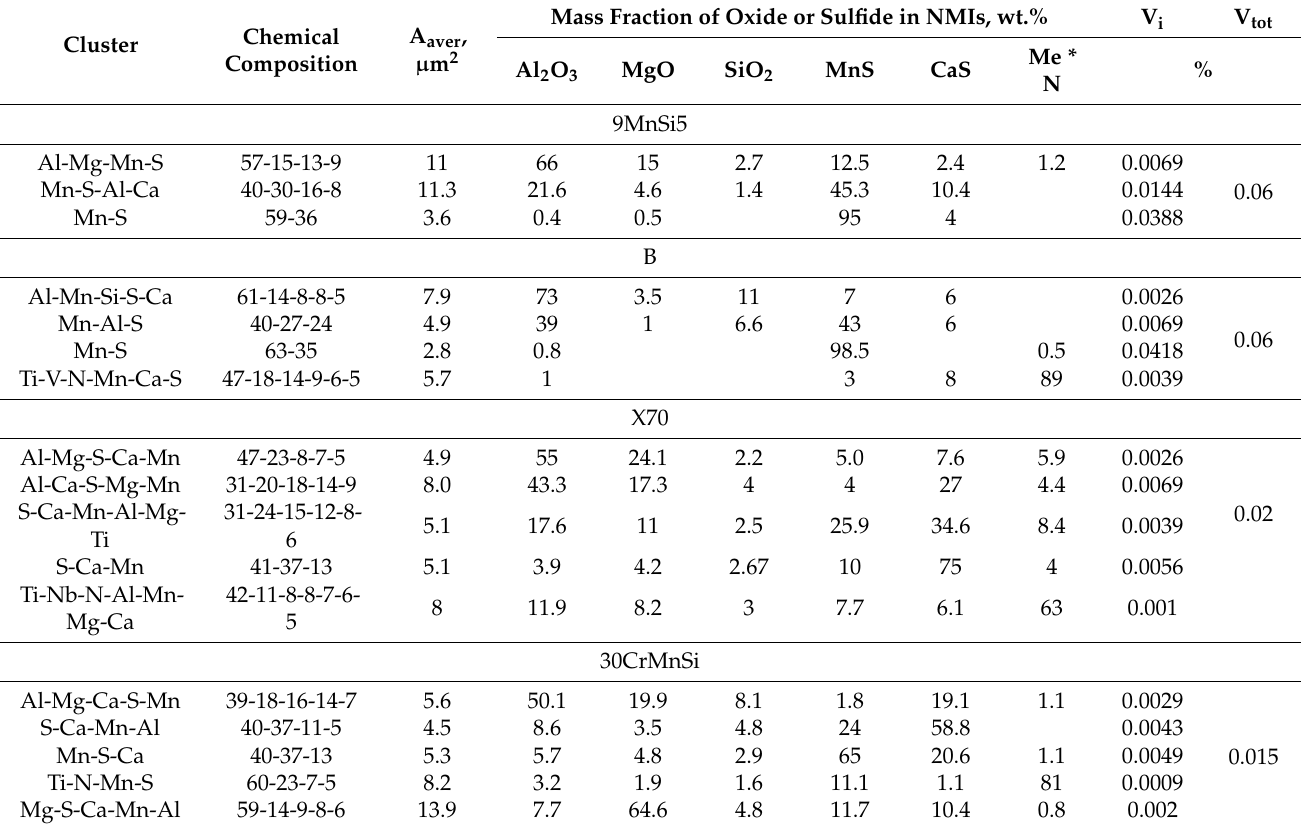
Table 4. Results of cluster analysis in the studied